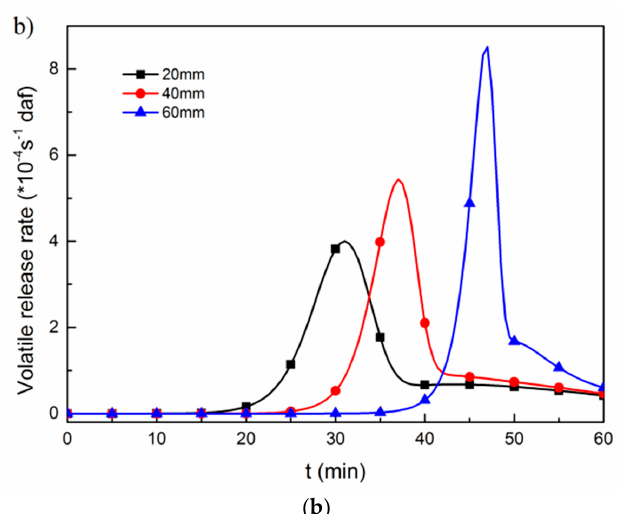
Figure 7. Effect of coal size on the volatile yield ( a ) and its release rate ( b ) at center of coal particle, 10 °C/min.